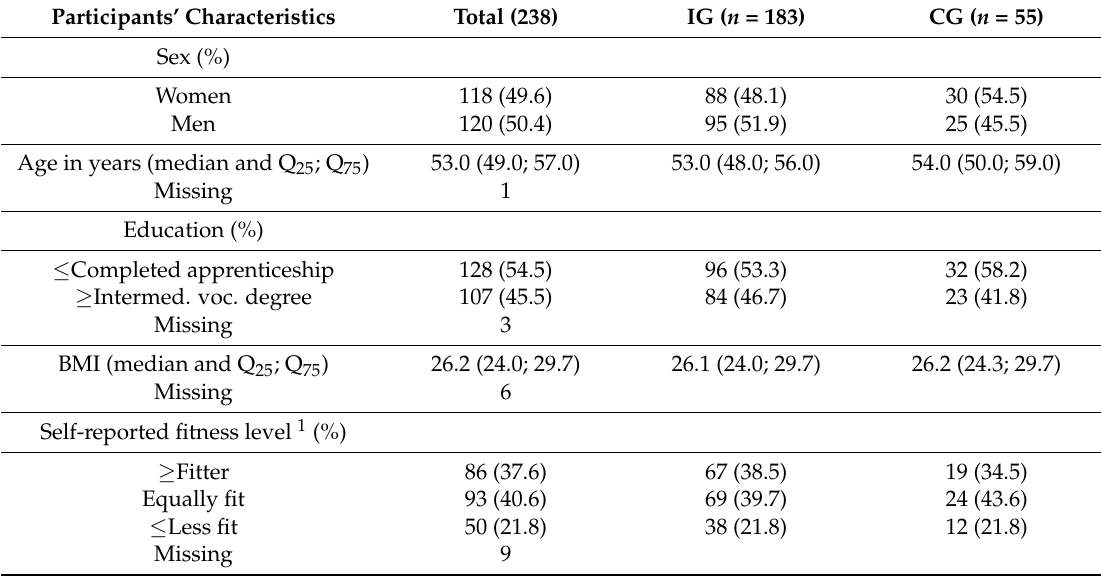
Table 1. Characteristics of participants who agreed to the 2nd PA measurement ( n =